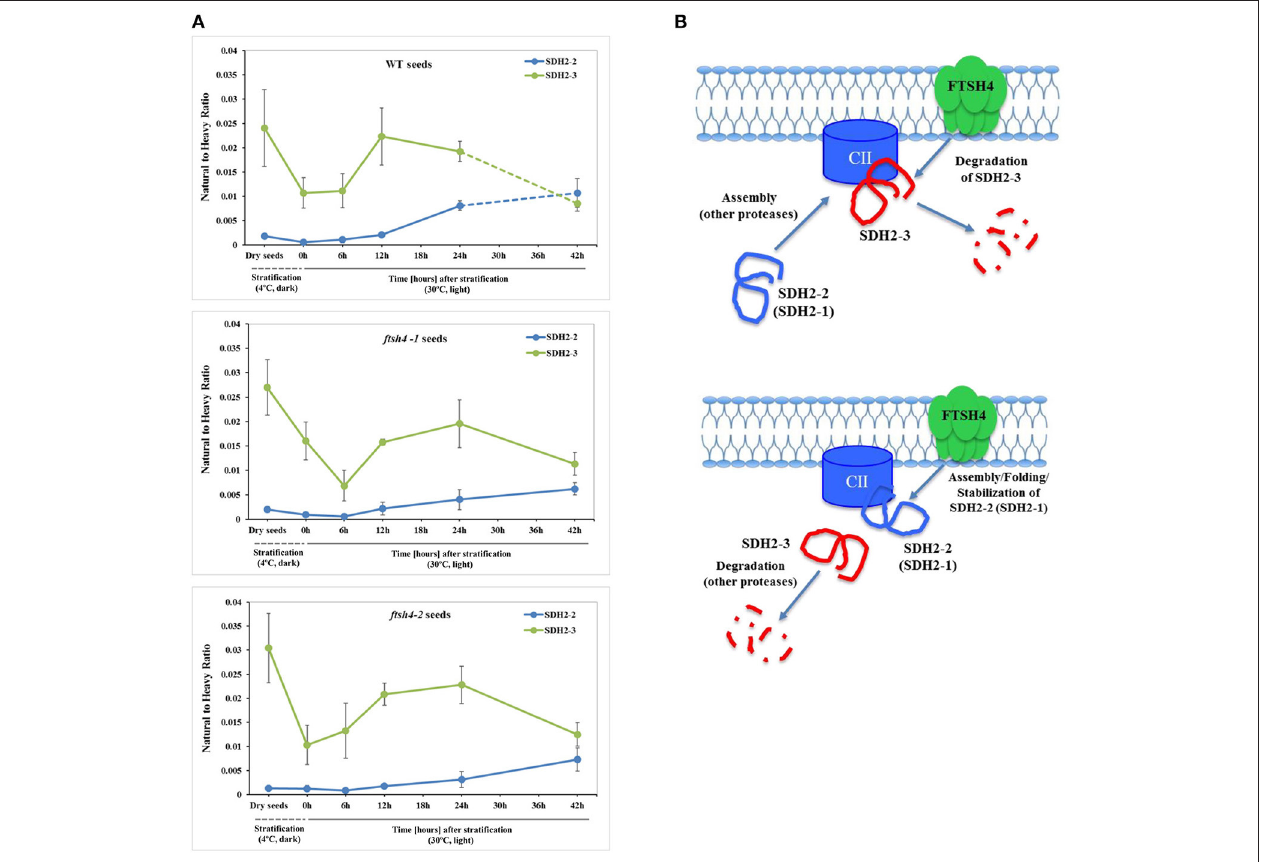
FIGURE 12 | Biogenesis of complex II in germinating Arabidopsis seeds. (A) Quantitative comparative time-course profiling of the iron-sulfur subunits of complex II, SDH2-2 and seed-specific SDH2-3, in the wild-type and ftsh4 seeds, estimated by MRM. Details regarding SDH2-2 and SDH2-3 abundance are given in Figure 4 . The dashed line in the graph indicates the end of germination sensu stricto and the beginning of the next developmental phase. (B) Hypothetical role of the FTSH4 protease in the biogenesis of complex II during germination of A. thaliana. FTSH4 is involved in the degradation of the seed-specific SDH2-3 subunit of complex II at the end of the germination process (proteolytic function of the protease). FTSH4 is responsible for either the folding, assembly or stabilization of the SDH2-2 subunit of complex II (chaperone-like function of the protease).